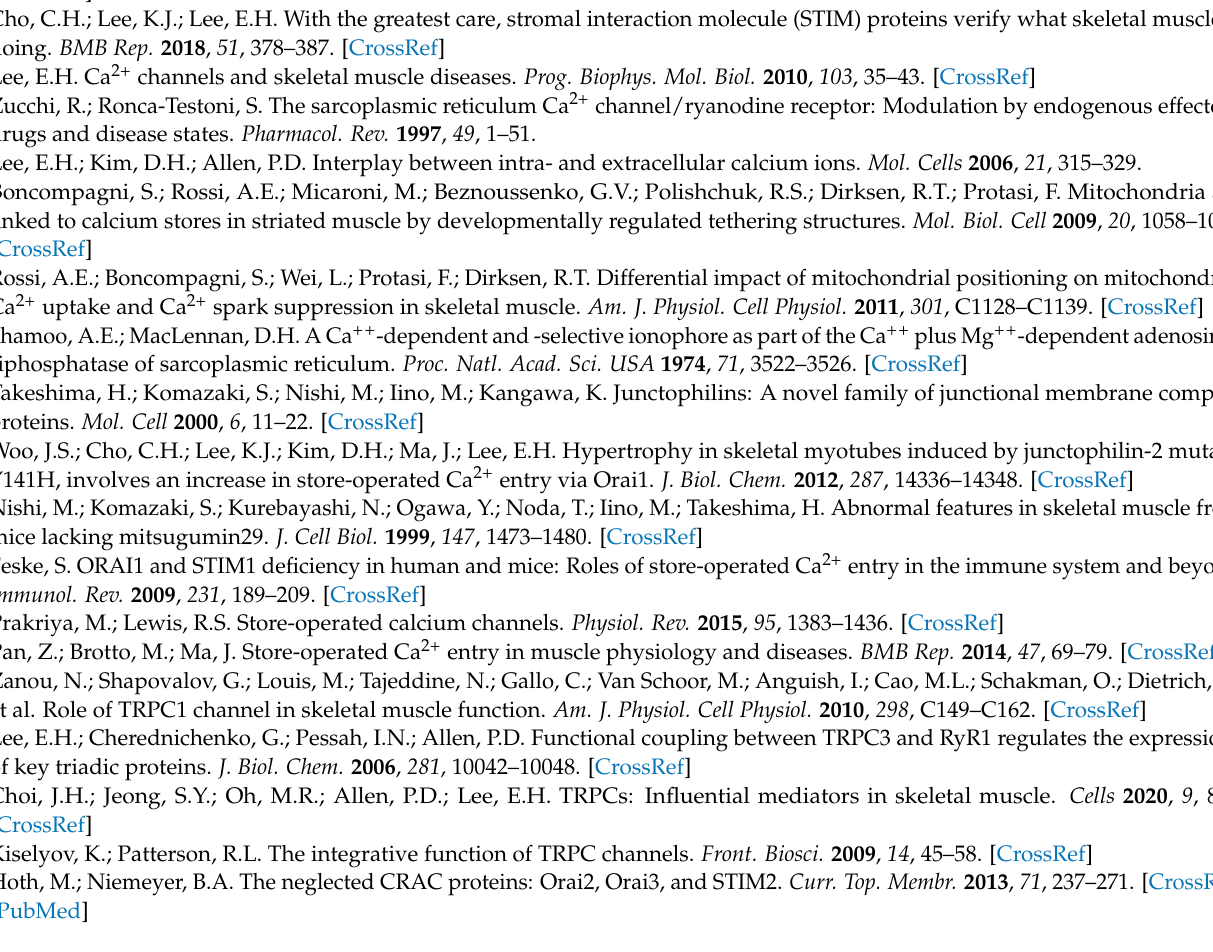
Table S3: PCR primers for the cloning of the C1 region into the pCMS-RFP vector. Table S4: Expression level of the proteins that mediate or regulate EC coupling, SOCE, or myotube differentiation in the WT CASQ1 or C1-expressing mouse primary skeletal